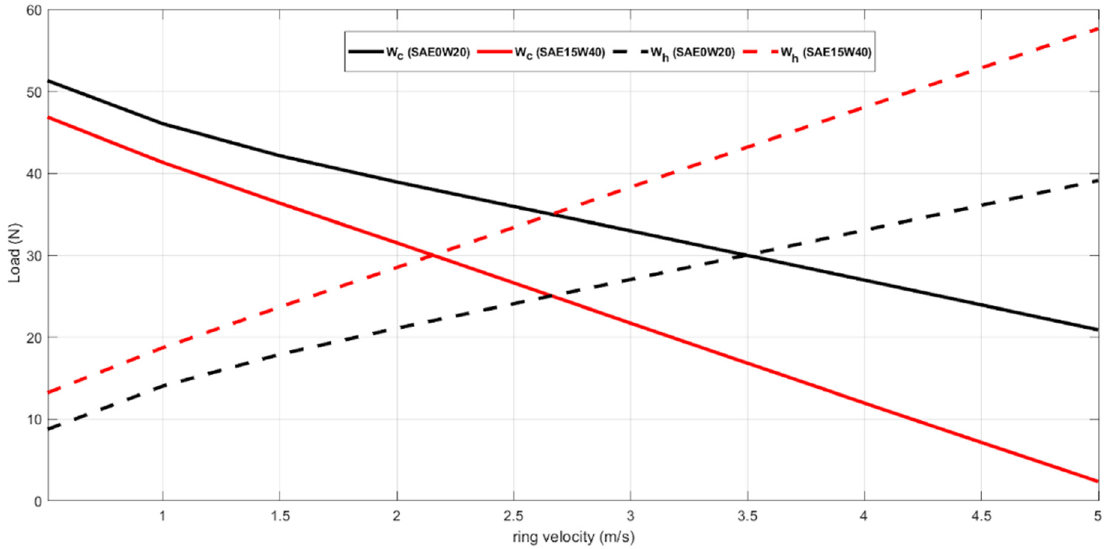
Figure 5. Comparison of hydrodynamic load and asperities load between SAE 0W20 and SAE 15W40 for CrN-coated rings with an uncoated cylinder liner.